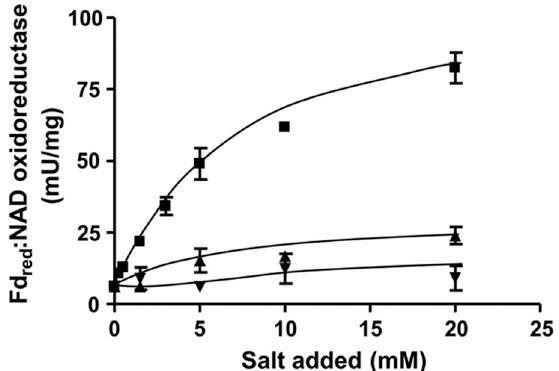
Figure 2. Na + dependence of ferredoxin:NAD + oxidoreductase (FNO) activity in C. aceticum . 250 µg of purified membrane were added to 1 mL buffer (20 mM Tris-HCl, 2 mM DTE, 2.2 µM resazurin, pH 7.7) and FNO was measured as described in Materials and Methods. Increasing amounts (0–20 mM) of NaCl ( ■ ), KCl ( ▲ ) or LiCl ( ▼ ) were applied to the assays. The contaminating Na + concentration was 104 µM. Results show data from two replicates.